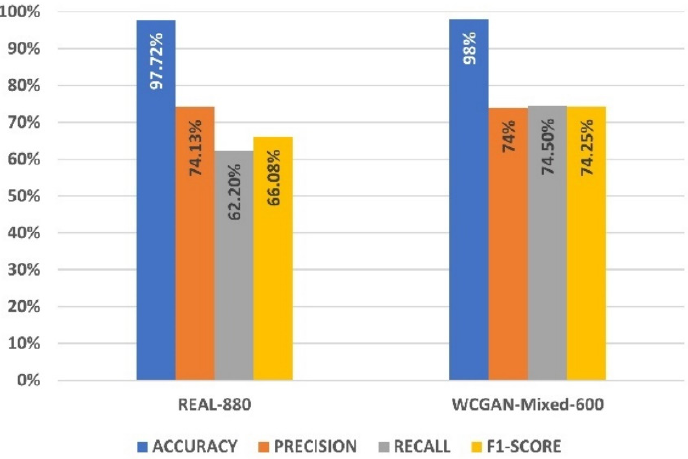
Figure 18. Histograms of the performance of our new best-performing GB-WCGAN-Mixed-600 classifier compared with our GB-REAL-880 classifier on the REAL-880 test set.